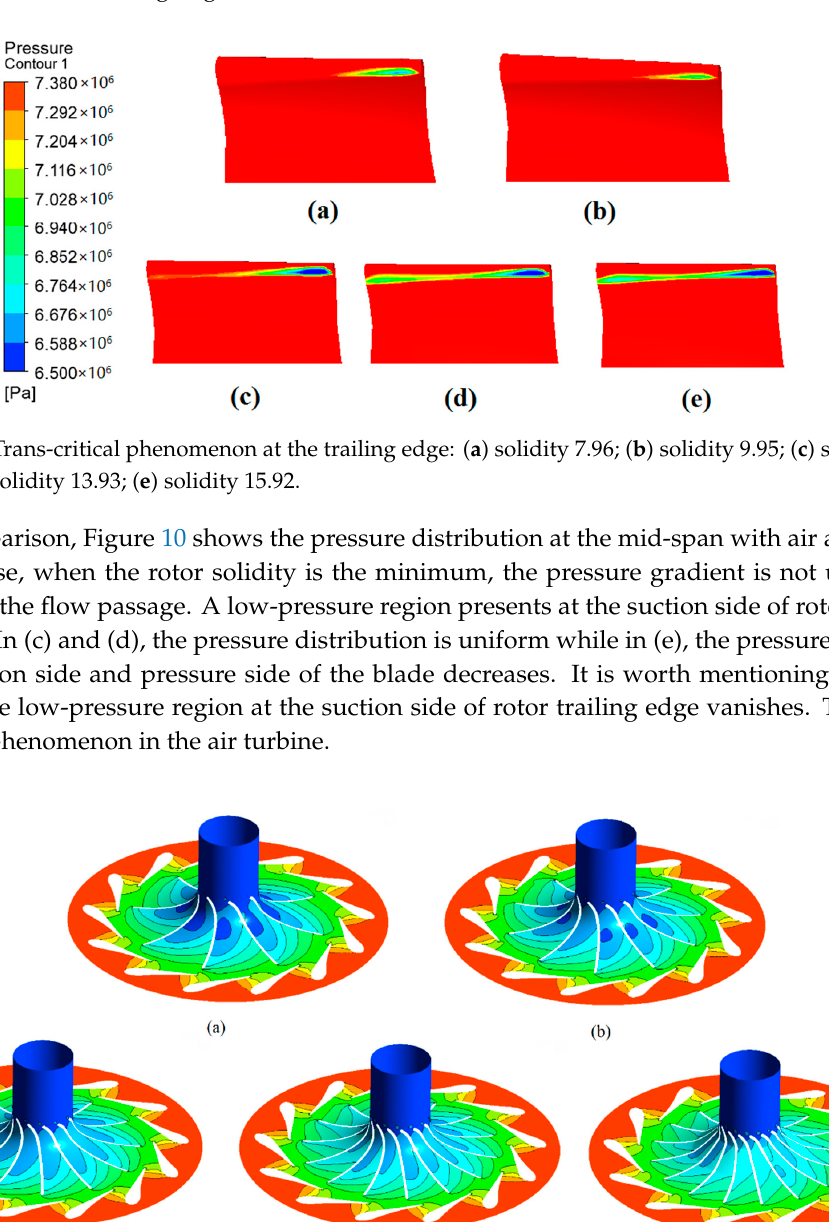
Figure 9. Trans-critical phenomenon at the trailing edge: ( a ) solidity 7.96; ( b ) solidity 9.95; ( c ) solidity 11.94; ( d ) solidity 13.93; ( e ) solidity 15.92.